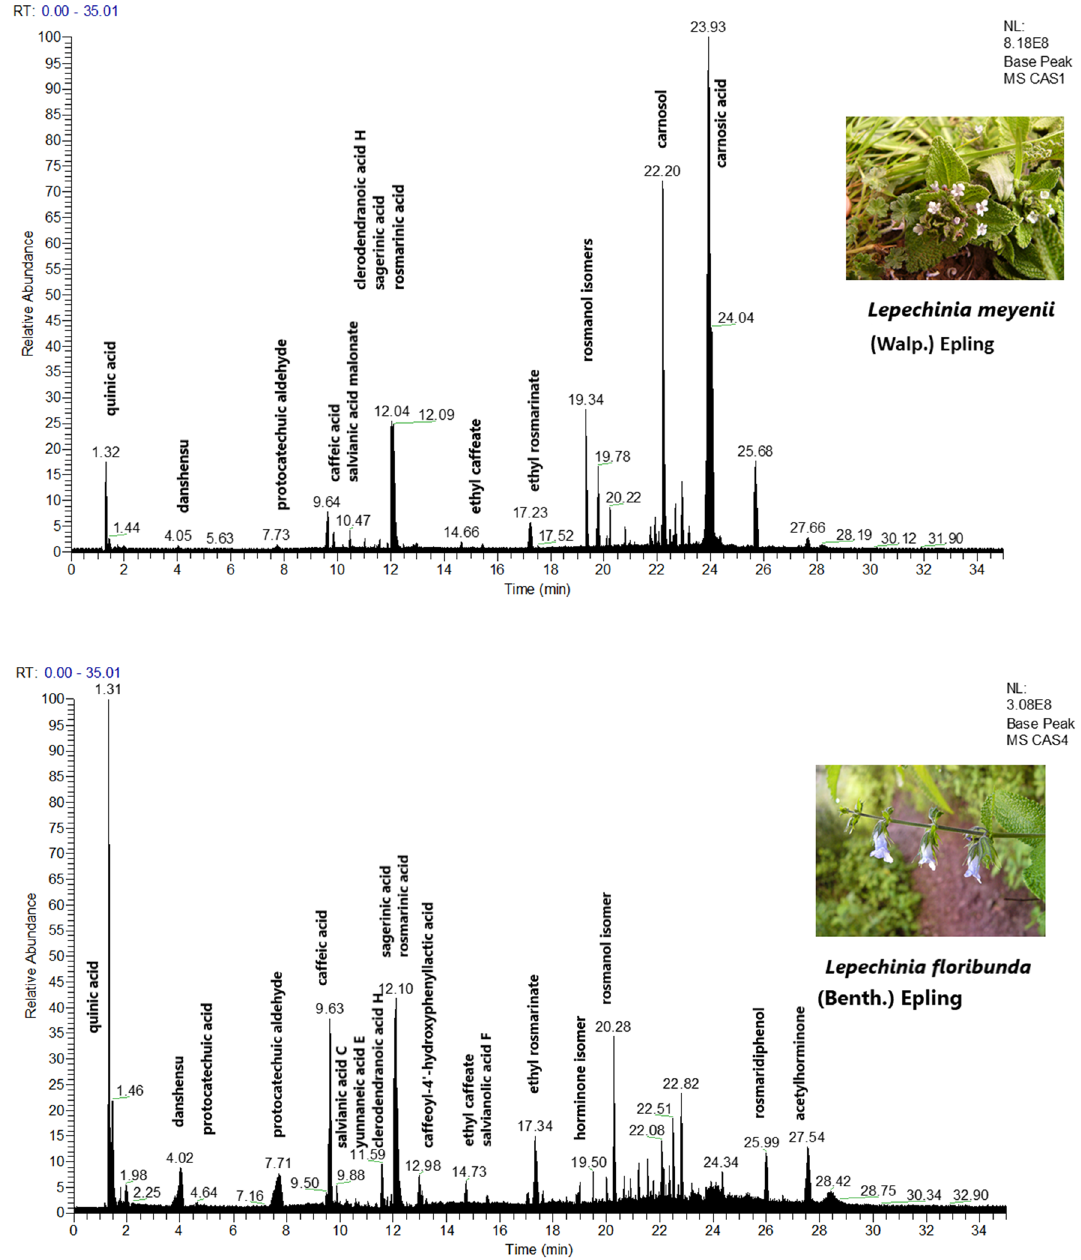
Figure 3. UHPLC/MSMS chromatograms of ethanolic extracts of L. meyenii and L.